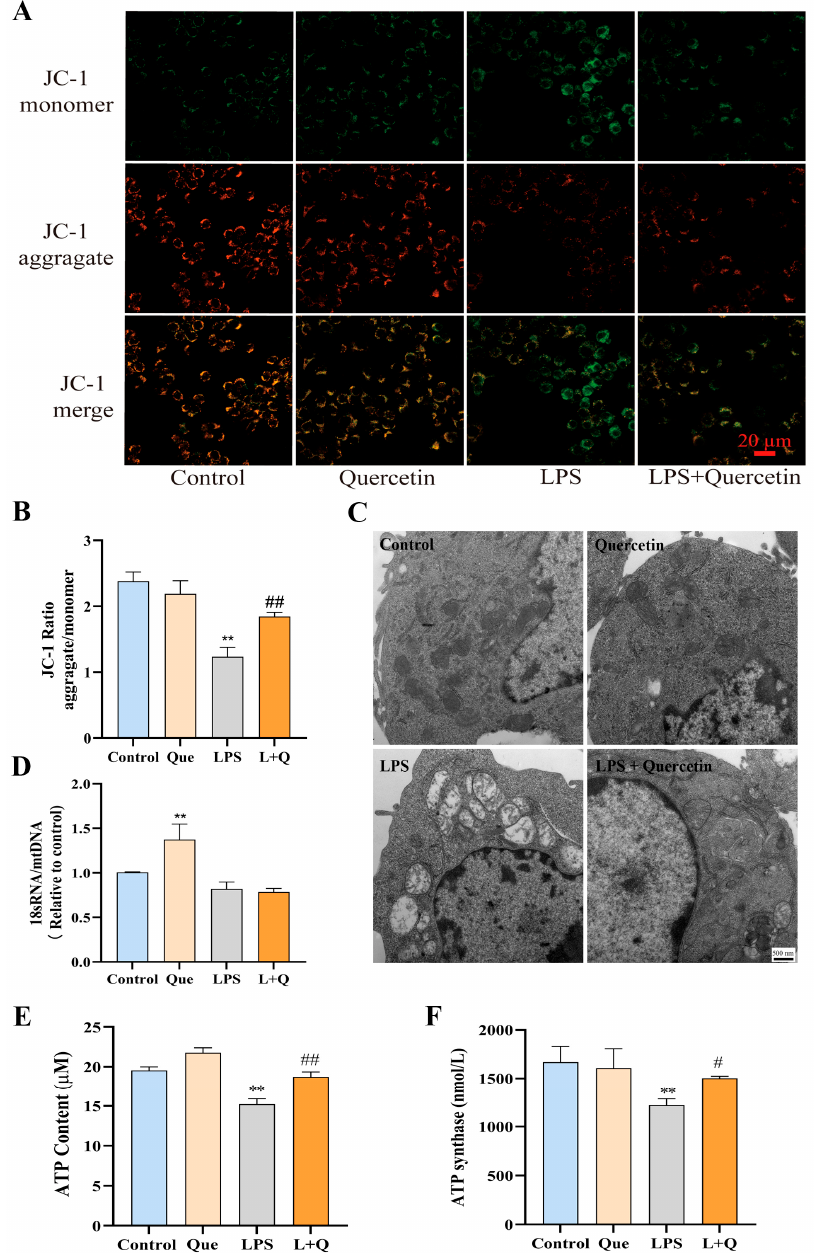
Figure 3. Effects of quercetin on the mitochondria of LPS-induced RAW267.4 cells. ( A ) Fluorescence intensity of cells stained with JC-1. Fluorescence intensity was measured using a multimode microplate reader at 485 nm excitation, 585 (red/orange for normal ∆ ψ ) and 538 (green for loss of ∆ ψ ) emissions, respectively. ( B ) The red/green fluorescence intensity ratio of JC-1 dye. ( C ) Transmission electron microscope images of mitochondria. ( D ) The mtDNA copy number of each treatment group. ( E , F ) The contents of ATP and ATP synthetase in each treatment group. ** p < 0.01 compared to the blank control group, and # p < 0.05 and ## p < 0.01 compared to the LPS group were considered statistically significant